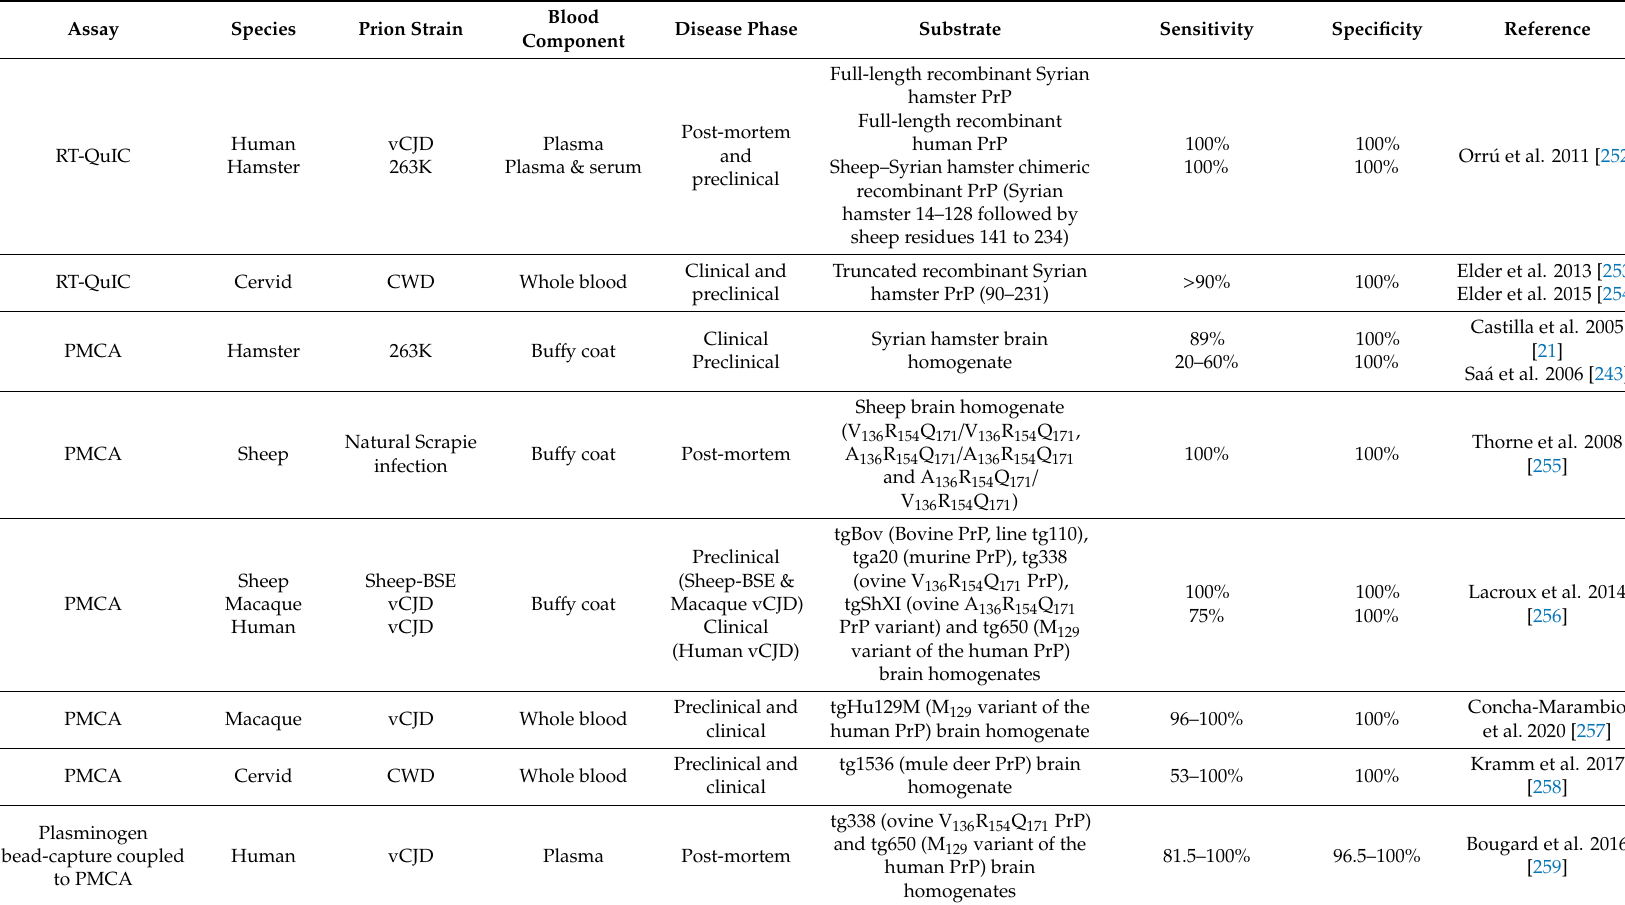
Table 2. List of studies performed using di ff erent techniques for the detection of scrapie isoform of the prion protein (PrP Sc ) in blood and blood fractions. The blood fraction in which PrP Sc presence was checked is detailed, as well as the disease stage at the sampling time when available. Prion protein (PrP), Variant Creutzfeldt-Jakob disease (vCJD), Chronic Wasting Disease (CWD), bovine spongiform encephalopathy (BSE), Real Time Quaking Induced Conversion (RT-QuIC), Protein Misfolding Cyclic Amplification (PMCA), Surround Optical Fiber Immunoassay (SOFIA), Direct Detection Assay (DDA), Rocky Mountain Laboratory mouse-adapted scrapie strain